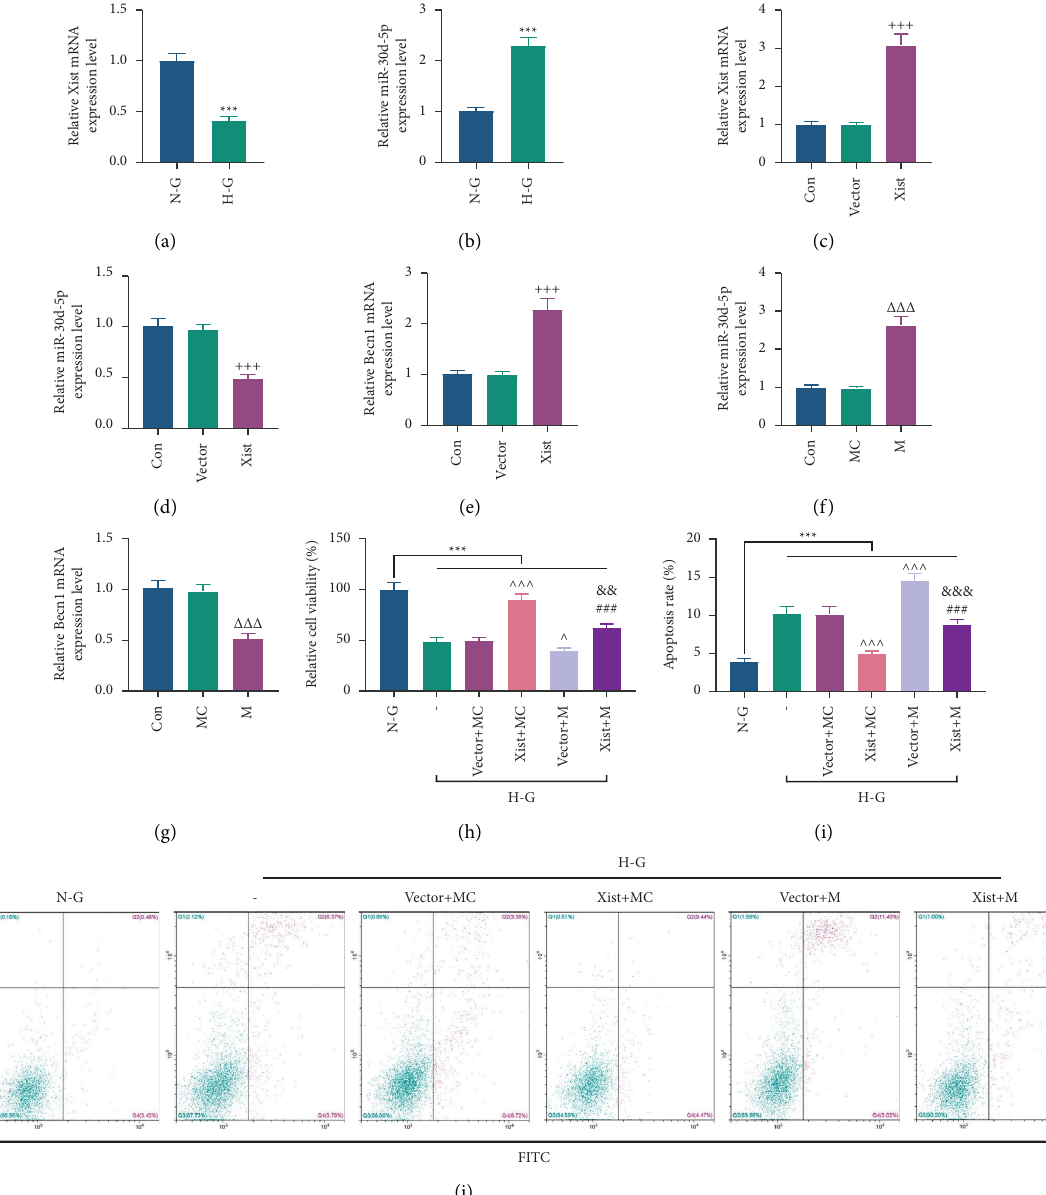
Figure 3: XIST targeted miR-30d-5p to regulate the viability and apoptosis of HG-induced podocytes. MPC5 cells were transfected with XISToverexpression plasmid/empty vector and or miR-30d-5p mimic/mimic control. (a-b) Te expression levels of XISTand miR-30d-5p in NG or HG-treated MPC5 cells were determined by qRT-PCR. GAPDH or U6 was used as the internal control. (c–e) Te expressions of XIST, miR-30d-5p, and BECN-1 in MPC5 cells transfected with XIST overexpression plasmid or empty vector were determined by qRT- PCR. GAPDH or U6 was used as the internal control. (f-g) Te expressions of miR-30d-5p and BECN1 in MPC5 cells transfected with miR- 30d-5p mimic/mimic control were determined by qRT-PCR. GAPDH or U6 was used as the internal control. (h–j) Te frst two groups of MPC5 cells were treated with NG or HG. Te last four groups of MPC5 cells cotransfected with XISToverexpression plasmid/empty vector and miR-30d-5p mimic/mimic control were treated with HG. (h) Te viability of MPC5 cells was determined by CCK-8 assay. (i-j) Te apoptosis of MPC5 cells was determined by fow cytometry. Quantifed values were presented as mean ± standard deviation of at least three independent experiments. +++ p < 0 . 001 vs. vector. △△△ p < 0 . 001 vs. MC. ∗∗ p < 0 . 001 vs. NG. ^ p < 0 . 05, ^^^ p < 0 . 001 vs. vector+MC. ### p < 0 . 001 vs. XIST+MC. && p < 0 . 01, &&& p < 0 . 001 vs. vector+ M. HG: high glucose. NG: normal glucose. M: mimic. MC: mimic control. qRT-PCR: quantitative real-time polymerase chain reaction. GAPDH: glyceraldehyde-3-phosphate dehydrogenase; XIST: X inactive specifc